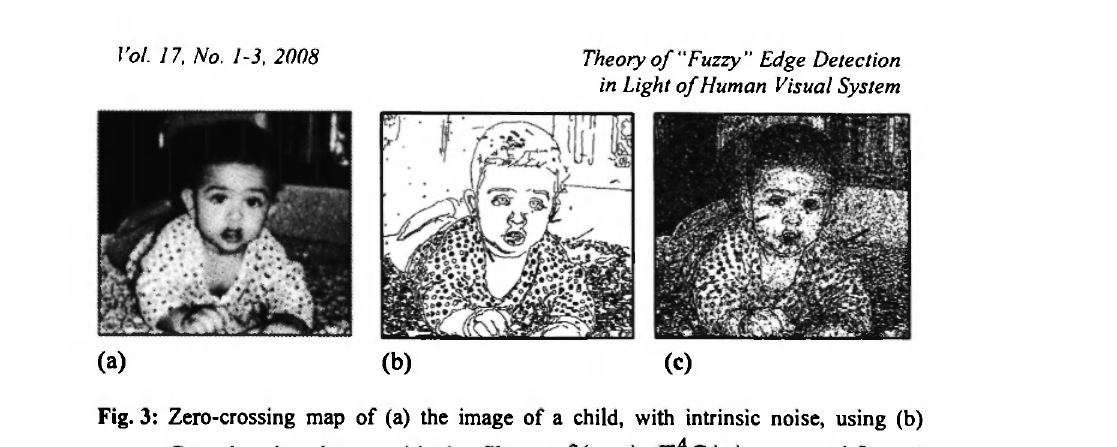
Fig. 3: Zero-crossing map of (a) the image of a child, with intrinsic noise, using (b) Canny's edge detector (c) the filter mS(x,y) + V 4 G f r) at <x = 1.2 and m = .01. The light and shade information of the image has clearly been